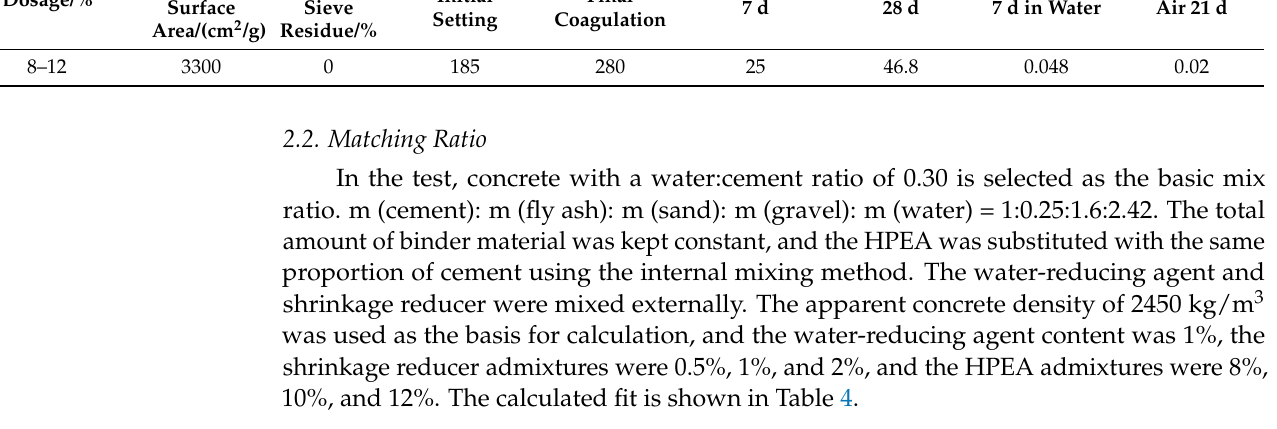
Table 4. Test mix design (kg/m 3